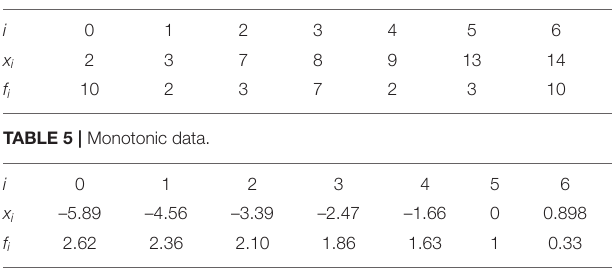
TABLE 4 | Positive data from Hussain and Ali [26].